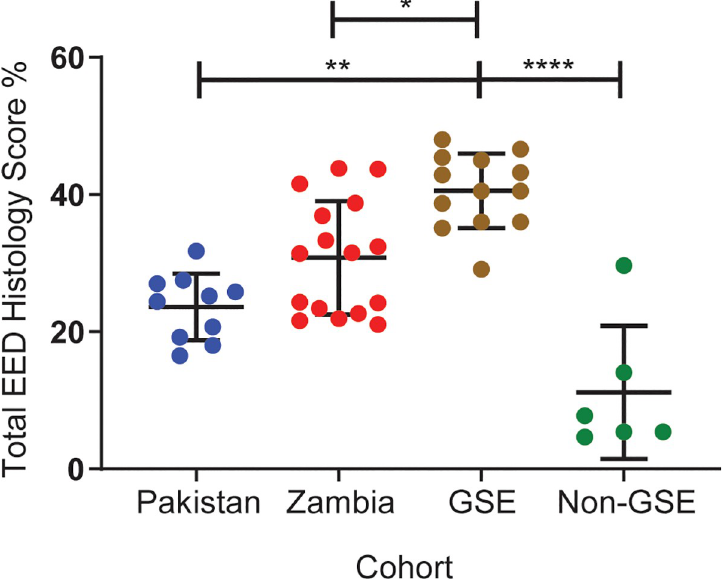
Fig 1. Total histology score percent, by cohort. Compared to the St. Louis GSE cohort, the St. Louis control, Pakistani and Zambian cohorts had lower total histology scores (p < 0.0001, p = 0.0005, and p = 0.02, respectively). Total histology score percent did not differ significantly between the Pakistani and Zambian WSIs (p = 0.13). Statistical analysis was performed by Kruskal-Wallis test followed by Dunn’s multiple comparisons test with Benjamini- Hochberg correction for false discovery error rate. � : p � 0.05; �� : p � 0.01; ���� : p � 0.0001. The bars indicate mean ± standard deviation.